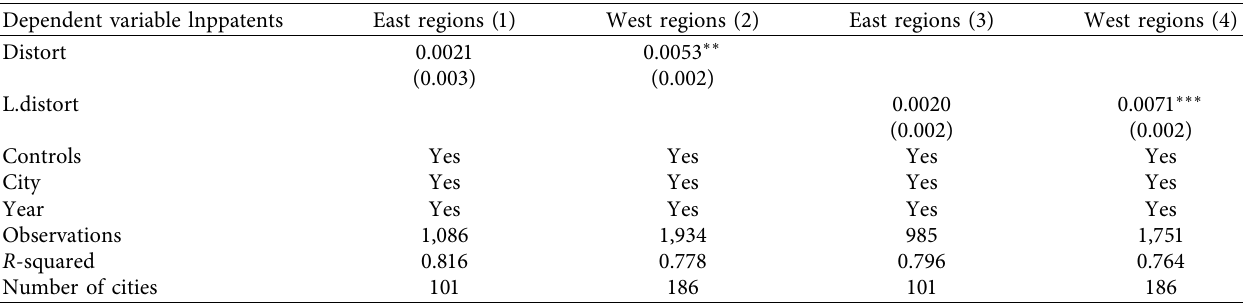
Table 9: Regional heterogeneity